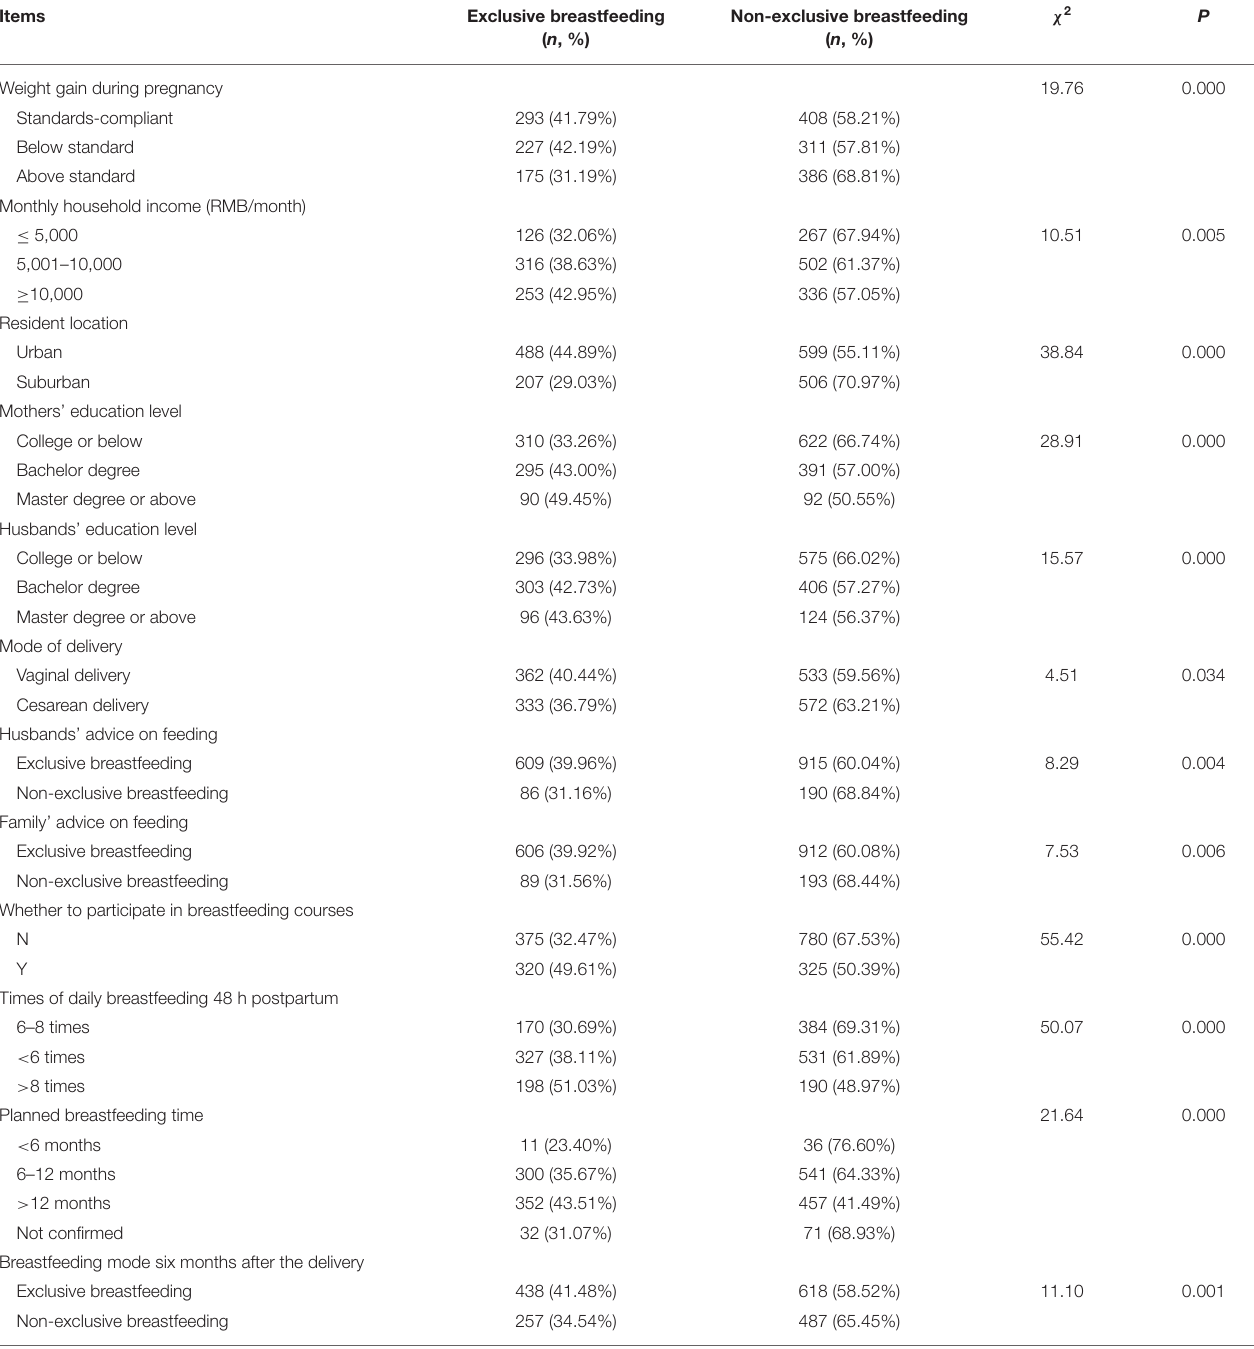
TABLE 5 | K-M analysis of exclusive breastfeeding in full-term infants within six